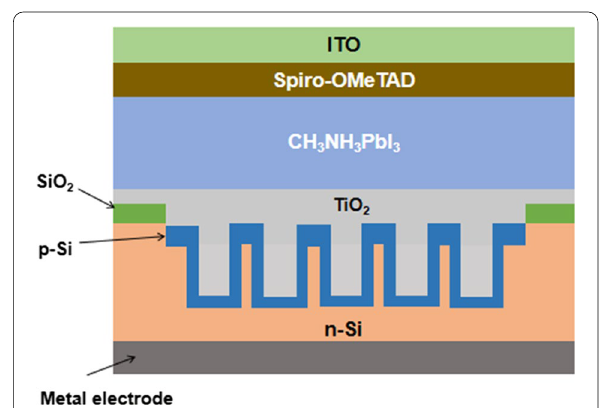
Fig. 2 a Schematic of the nanoholes array used in the model. b 2D side view of an individual